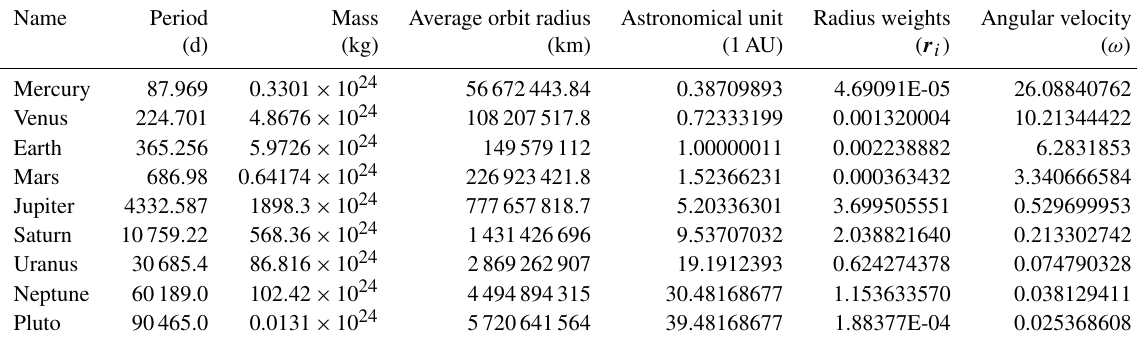
Table 2. Astronomical data of